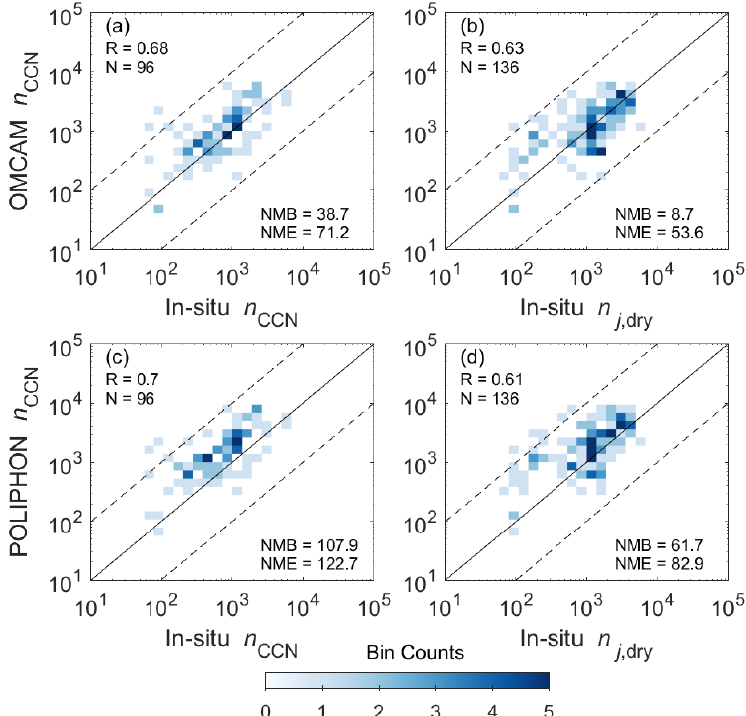
Figure 4. Comparison of n CCN ( a , c ) and n j, dry ( b , d ) from in situ and CALIOP (day and night combined) measurements using OMCAM ( a , b ) and POLIPHON ( c , d ) for N bins > 100 at all sites given in Table 1.